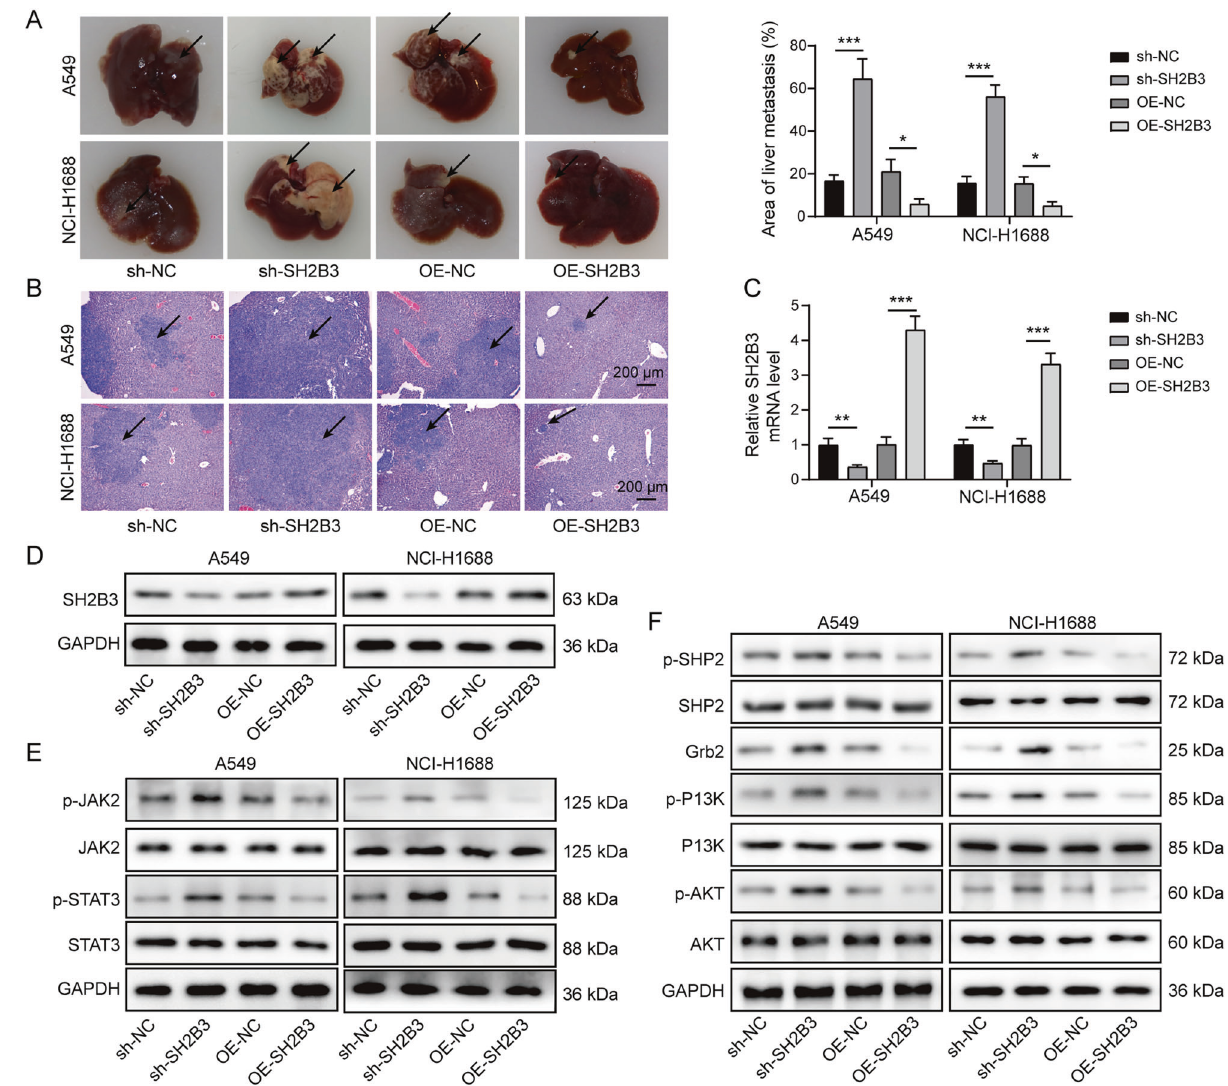
Fig. 7 SH2B3 inhibited lung cancer metastasis in vivo. A The area of tumor nodules in the liver of each group. B H&E staining of metastatic lesions in the liver of each group. C qRT-PCR analysis of SH2B3 mRNA levels in the liver tissues of each group. D Western blotting to measure SH2B3 protein levels in the liver tissues of each group. E Western blotting to determine p-JAK2, JAK2, p-STAT3, and STAT3 in the liver tissues from each group of mice. F Western blotting to determine p-SHP2, SHP2, Grb2, p-PI3K, PI3K, p-AKT, and AKT in the liver tissues from each group of mice. *** P < 0.001 and ** P <